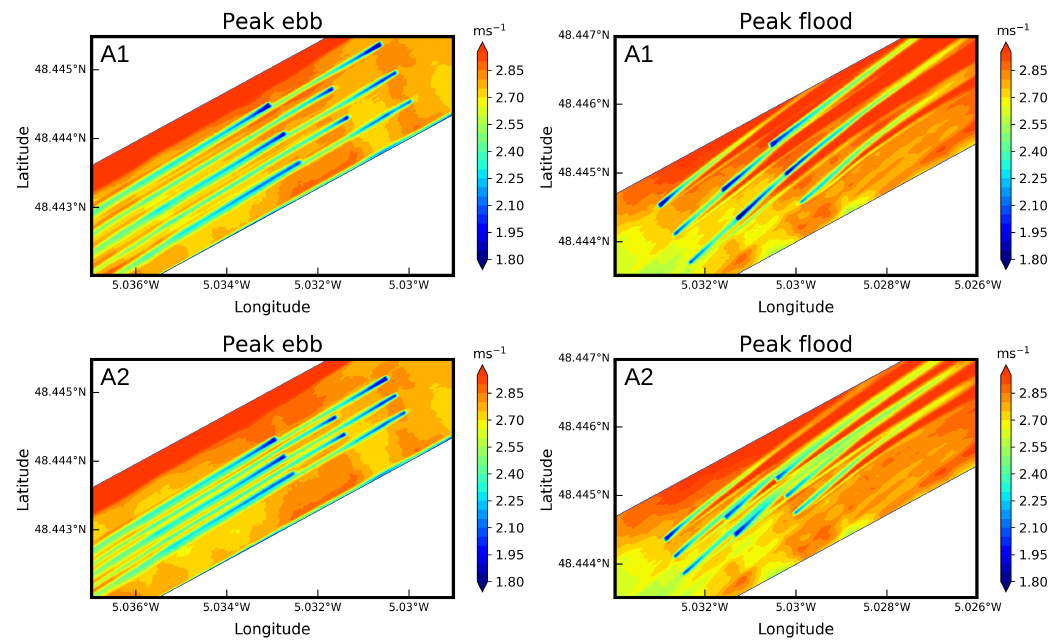
Figure 12. Horizontal plane maps of current magnitudes at peak ebb and flood of a mean spring tide in the Fromveur Strait for ( top ) the initial array layout A1 and ( bottom ) the optimized array configuration A2 that restricted wake interactions in peak flood (adapted from [25]). This horizontal plane grid corresponds to a reference elevation of 10 m above the bottom at a point located at the center of the computational domain. This reference plane may therefore be located below or above the different turbine centers but disregards the seabed variation focusing on wake horizontal